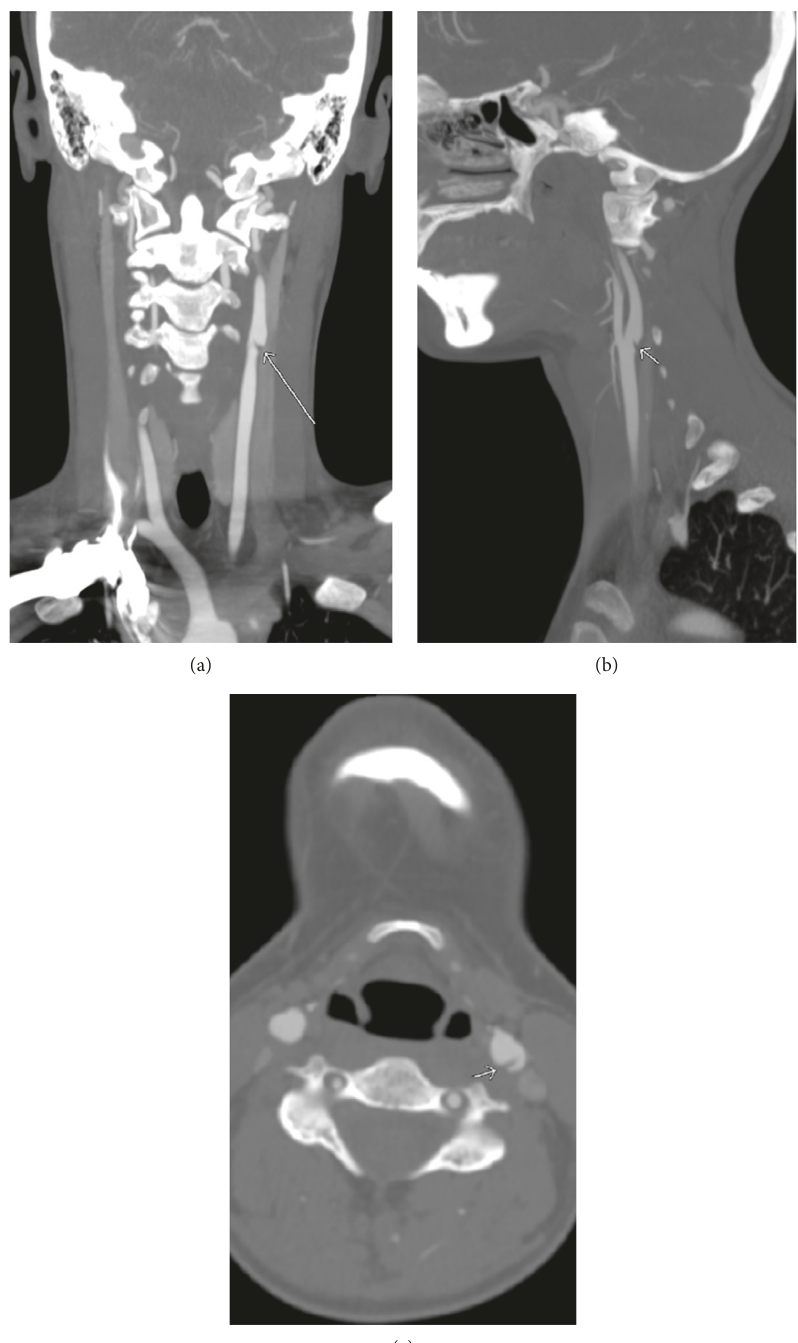
Figure 4: CTA neck showing carotid web in the left internal carotid artery